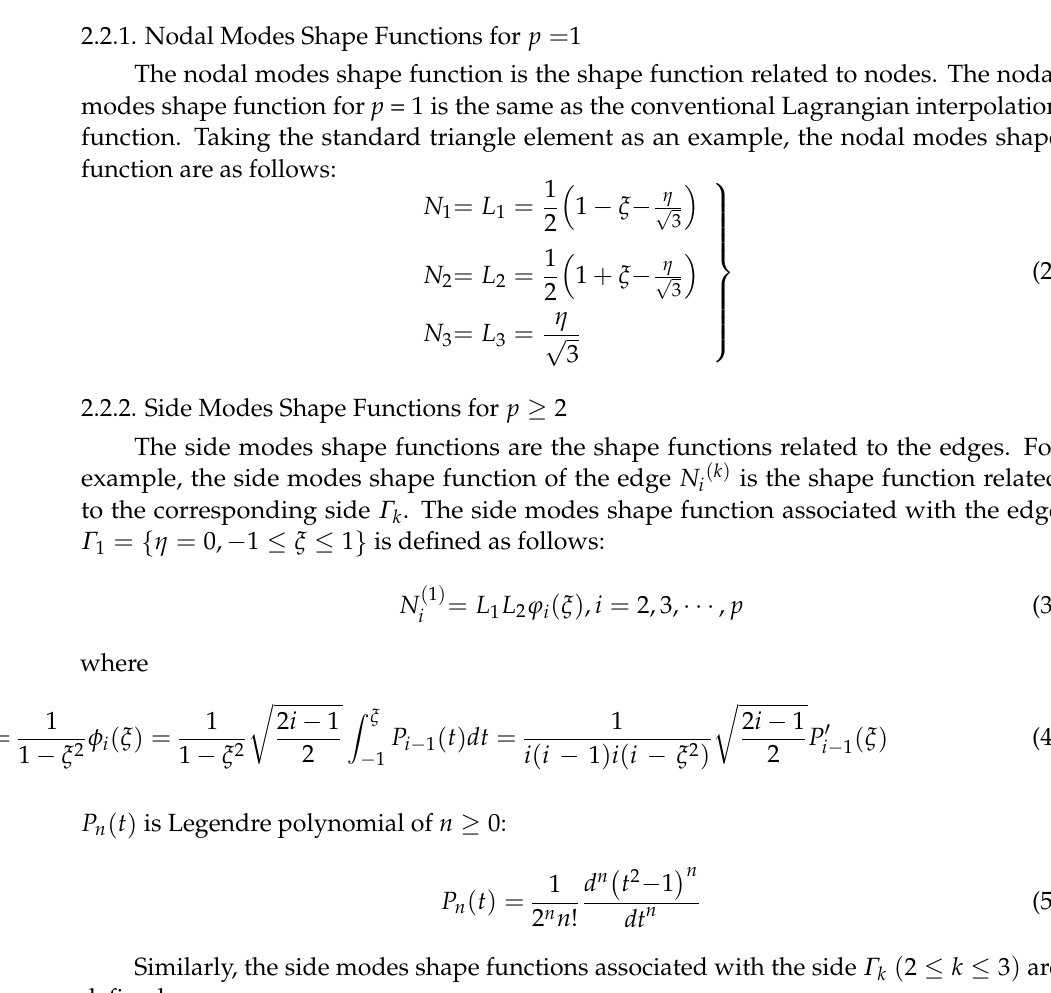
Figure 1. Standard triangle element T